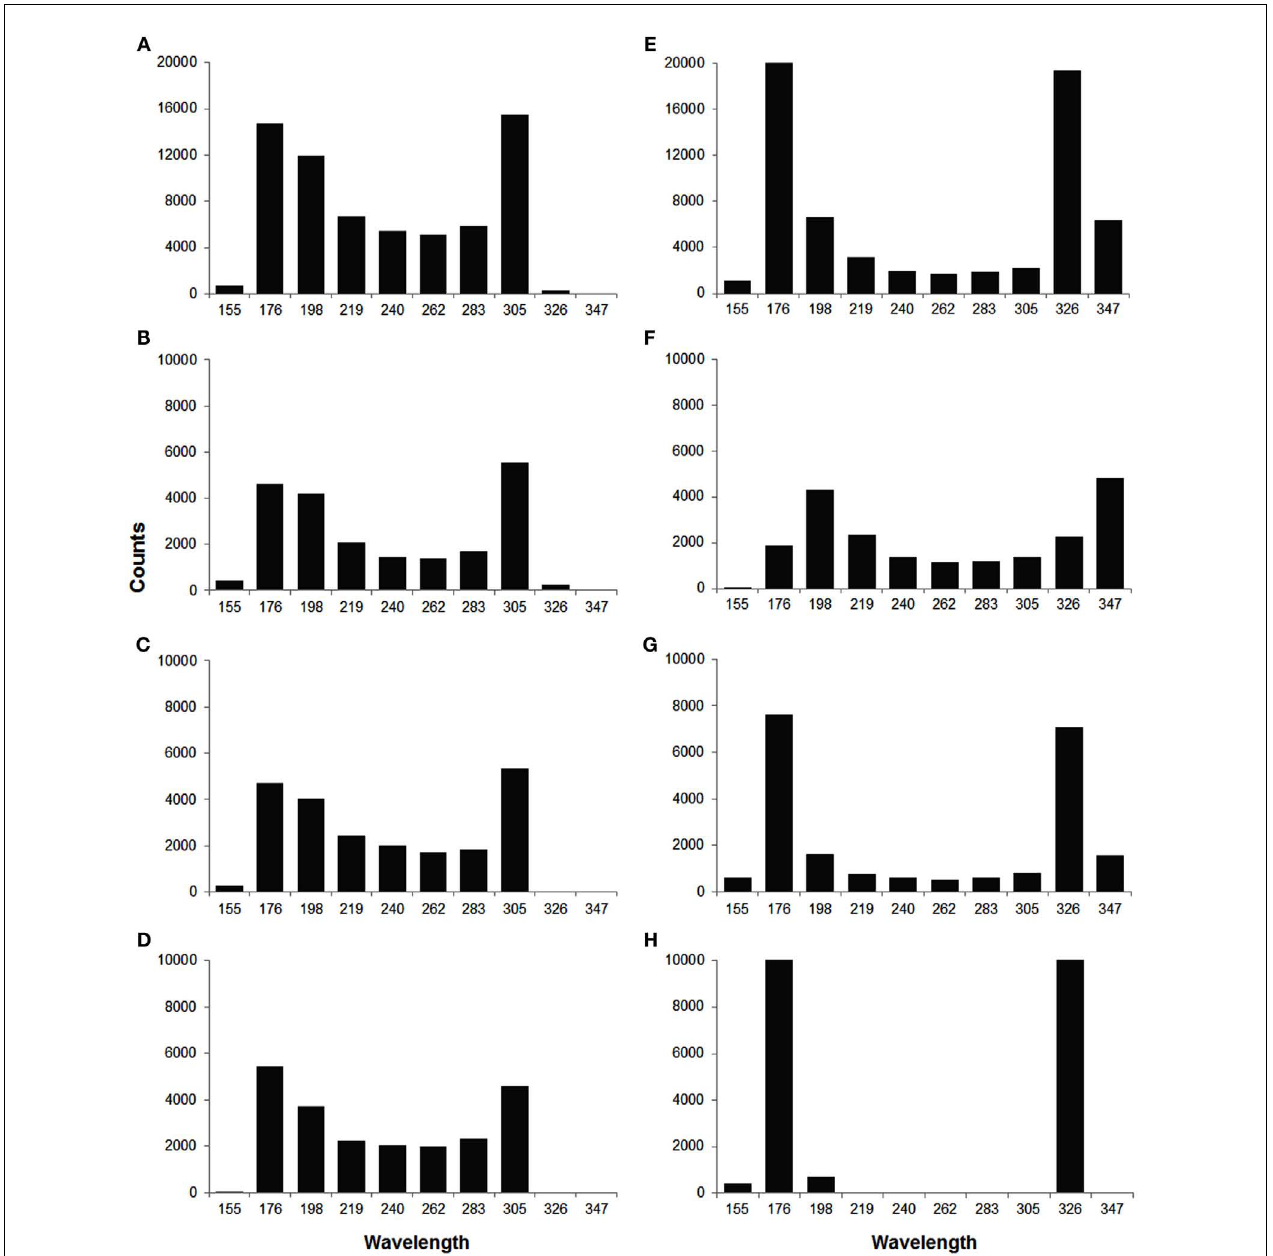
section. During in phase, the wavelength was more widely distributed between 150 and 350 (in number of cells), while during out of phase, it was more concentrated in two bins centered at 176 and 326, especially in the last section (H)